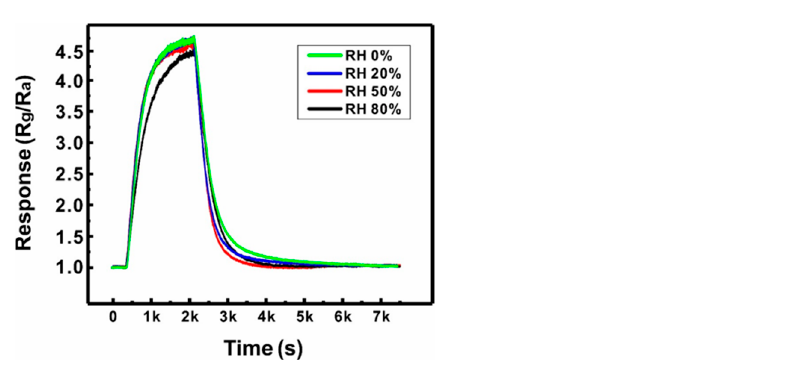
Figure 7. Effect of humidity (0, 20, 50, and 80% RH) on the gas response of a Type B sensor (500 ppb NO 2 , 250 °C).